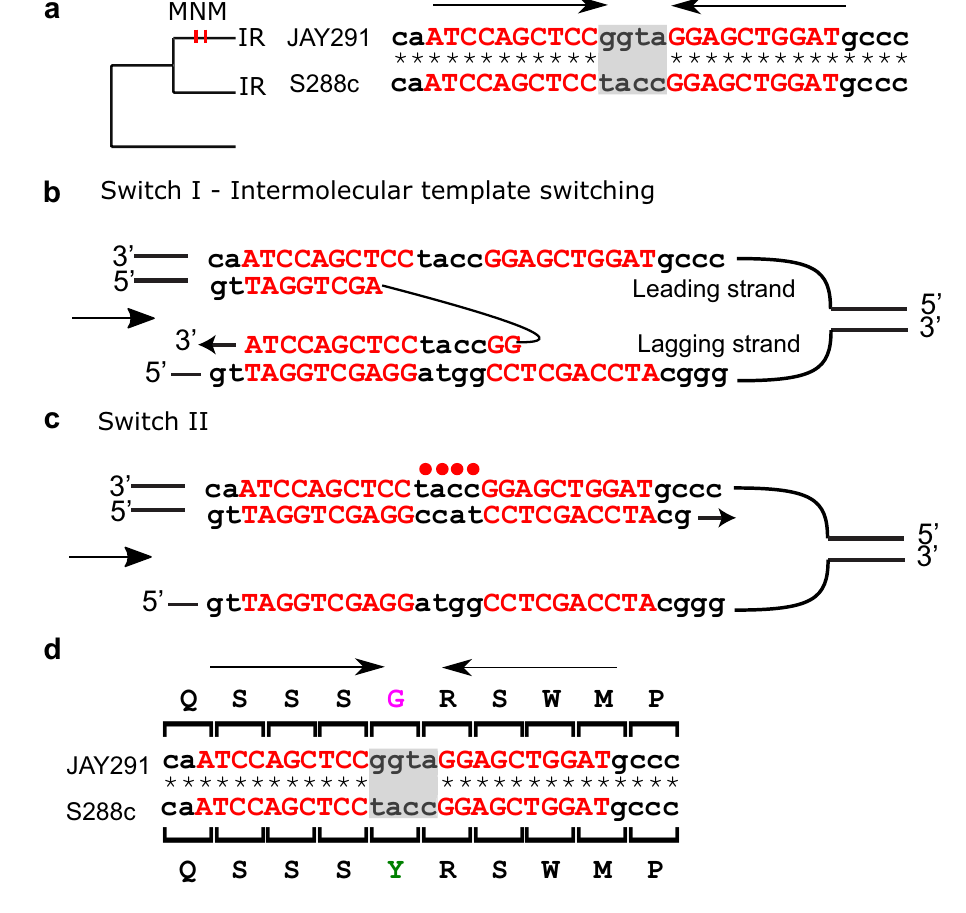
Figure 3. Intermolecular template switching causes spacer inversion. ( a ) A perfect IR in JAY291 on SYG1 overlapping with a MNM located on the spacer. The MNM occurred in the branch leading to JAY291 (shown as vertical lines on the tree). In this case, the sister taxon, represented here by S288c, also has a perfect IR with the same arms. ( b ) The mechanism that created spacer inversion (AAGTC → GACTT) was intermolecular template switching, with the first switch having occurred during synthesis of the first arm. ( c ) The second switch returned the nascent strand to the original template, resulting in an inverted spacer of JAY291 compared to S288c. ( d ) IR spacer inversion resulted in one amino acid replacement (Y46G) in JAY291. Uppercase letters represent the IR arms, with the same arms shown in the same color. The red dots represent mismatches. The direction of the replication fork is indicated by an